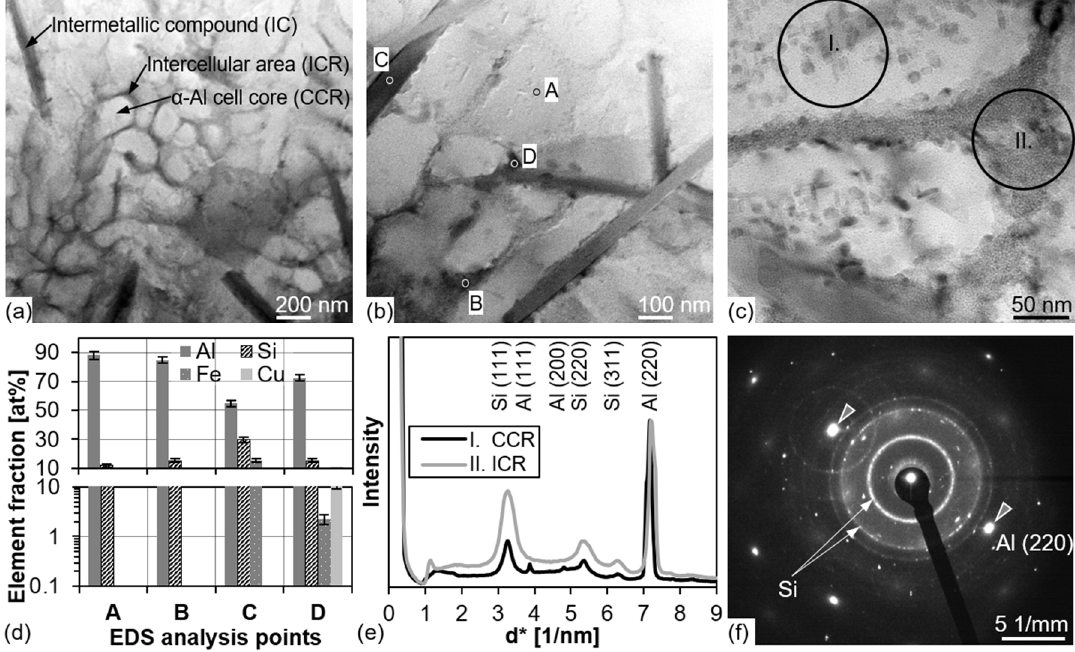
Figure 5. EB remelted microstructure: ( a ) TEM bf image overview with characteristic microstructural areas (IC—intermetallic compounds; CCR—cell core region; ICR—intercellular region); ( b ) detailed image with EDS measuring points (A–D); ( c ) detailed image with SAED measuring areas: I. cell core (CCR), II. intercellular region (ICR); ( d ) EDS analysis (d*–reciprocal lattice plane spacing) of measuring points marked in ( b ); ( e ) radial intensity distribution of the diffraction patterns from area I. and II. marked in ( c ); ( f ) diffraction pattern from <116>-beam direction.